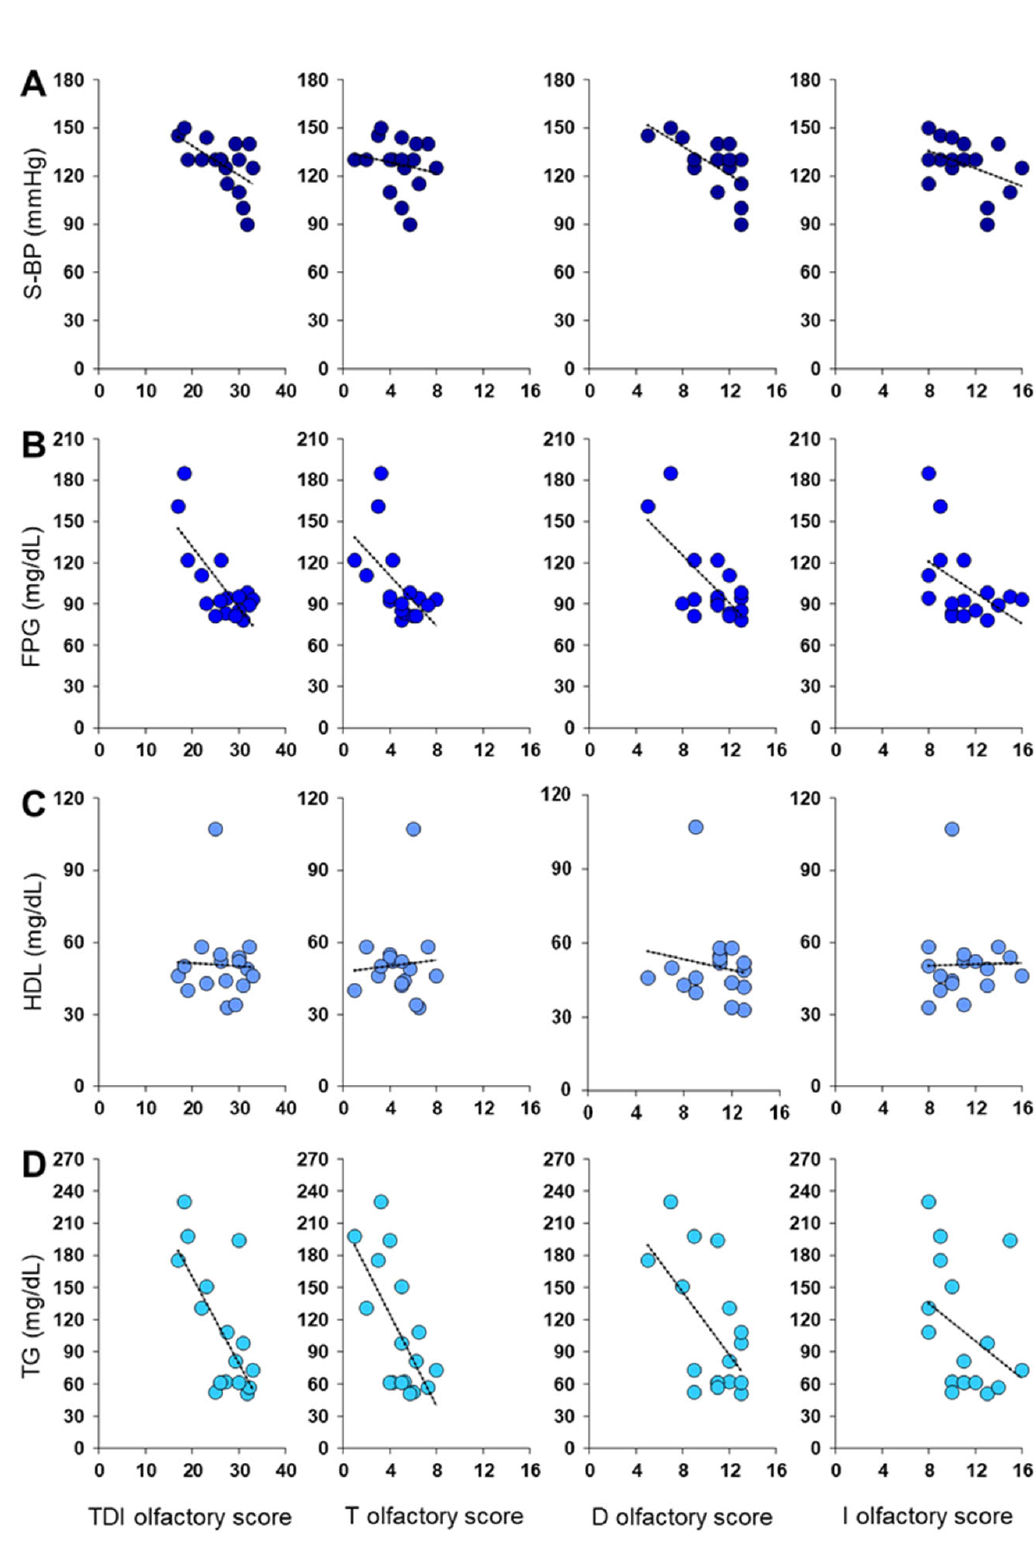
Figure 4. Correlation analysis between olfactory scores obtained by each male patient and his ( A ) Systolic Blood Pressure (S ‐ BP), ( B ) Fasting Plasma Glucose (FPG), ( C ) HDL levels, and ( D ) triglycerides levels (TG).